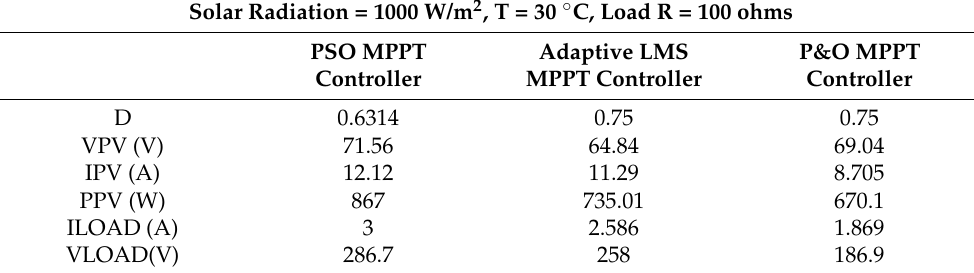
Table 10. Solar panel power, voltage, current, DC link voltage and current.